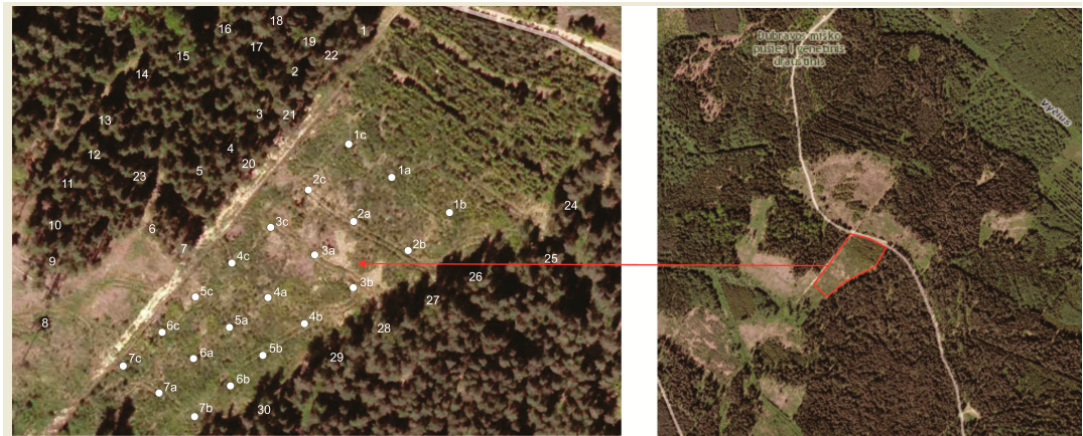
Figure 2. Sampling scheme in a self-regenerating cleared windthrow site (light green) within a Norway spruce stand and in a surrounding undisturbed stand with an admixture of putatively maternal Norway spruce trees (dark green area). White dots labeled with numbers from 1a to 7a show seven circular sampling plots in a regenerating site, while dots labeled with numbers from 1b to 7b and 1c to 7c show additional sampling locations. Numbers not associated with dots (1–30) indicate locations of sampled putative maternal (seed) trees in the undisturbed stand.